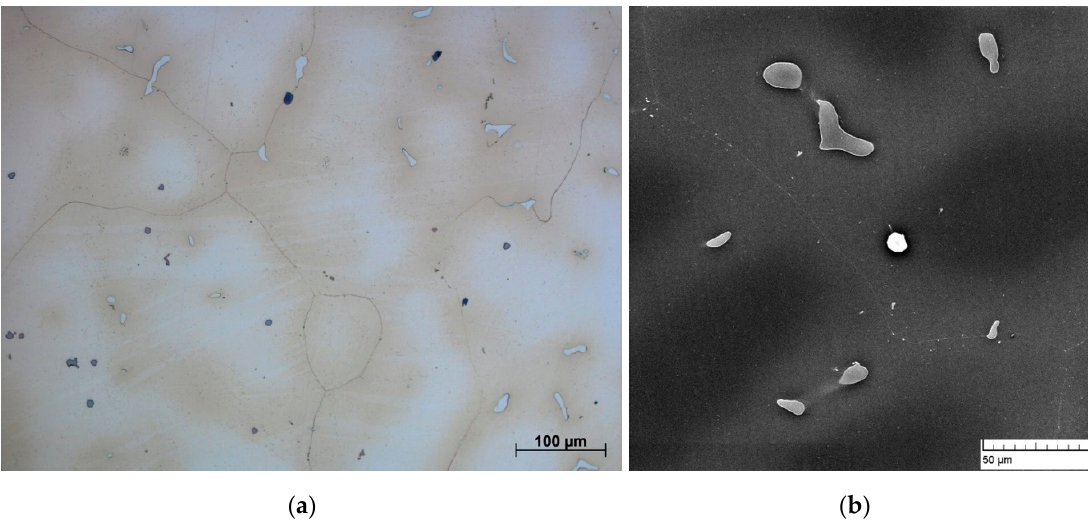
Figure 6. Microstructure of the AZ91 alloy after heat treatment. ( a ) Light micrograph. ( b ) Electron micrograph. Picric acid was used for etching.